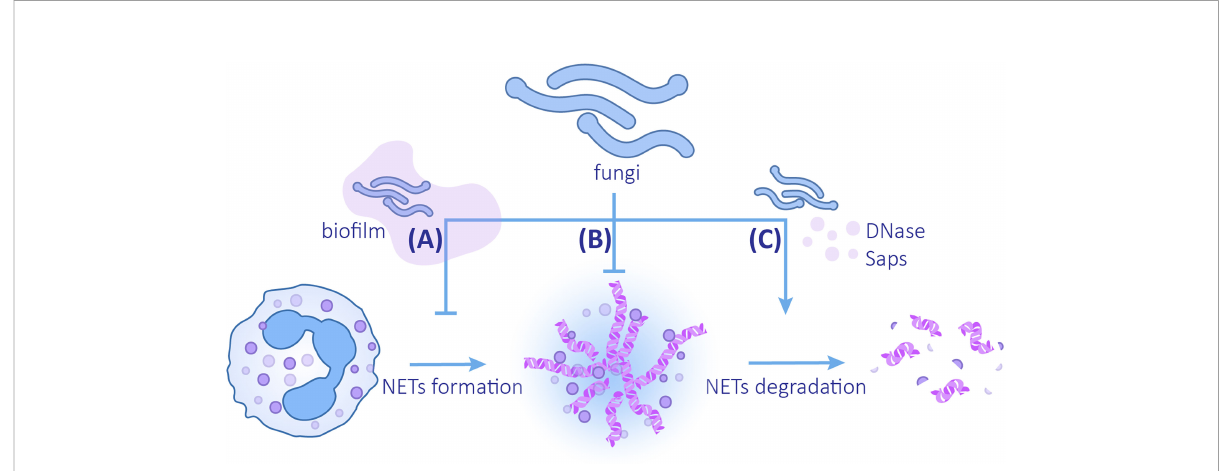
FIGURE 3 The mechanisms of fungi evading NETs (A) Fungi can reduce the release of NETs by forming bio fi lms. (B) Changes in fungal cell wall compositions and bio fi lm formation can enhance the ability to resist NETs. (C) Fungi can promote the degradation of NETs by secreting DNAse and